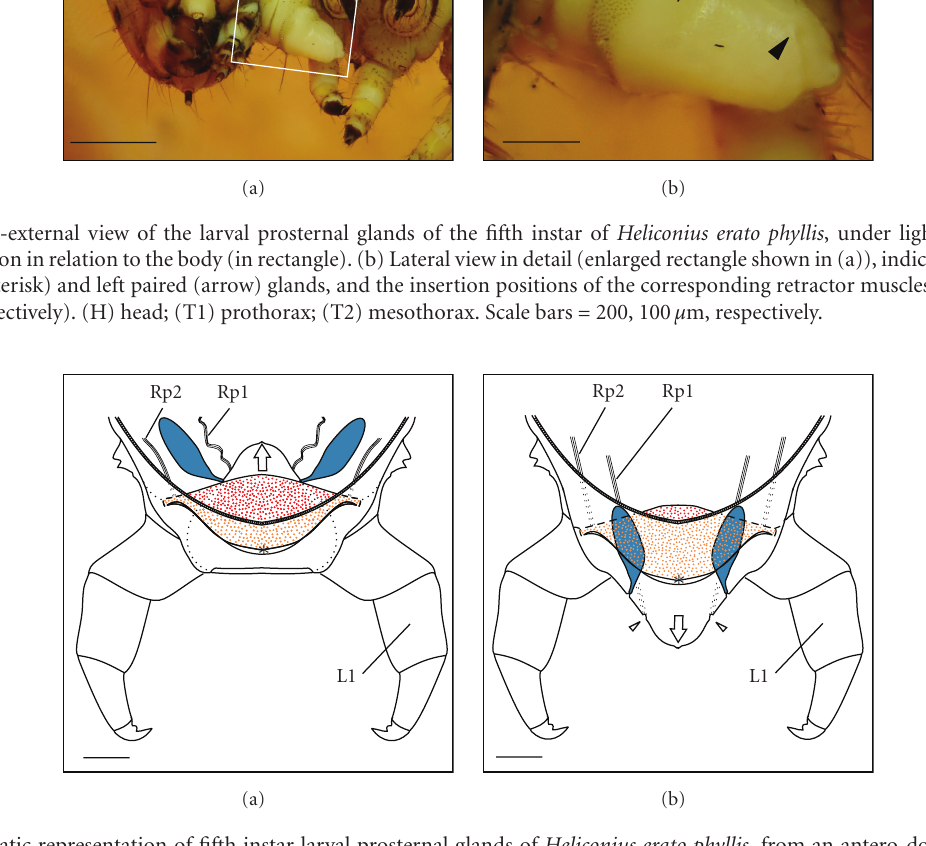
Figure 2: Schematic representation of fifth instar larval prosternal glands of Heliconius erato phyllis , from an antero-dorsal internal view, when in situ (a) and during extrusion of the prosternal sac (b). Impair and paired glands are shown in stippled red and solid blue, respectively. Open arrows indicate the direction of the internal hemostatic pressure and the respective movement of the prosternal sac. Impair and paired glandular openings are indicated by one asterisk and open arrowheads, respectively. (L1) prothoracic leg; (Rp1) proximal retractor muscle of the prosternal sac; (Rp2) distal retractor muscle of the prosternal sac. Scale bar = 50 µ